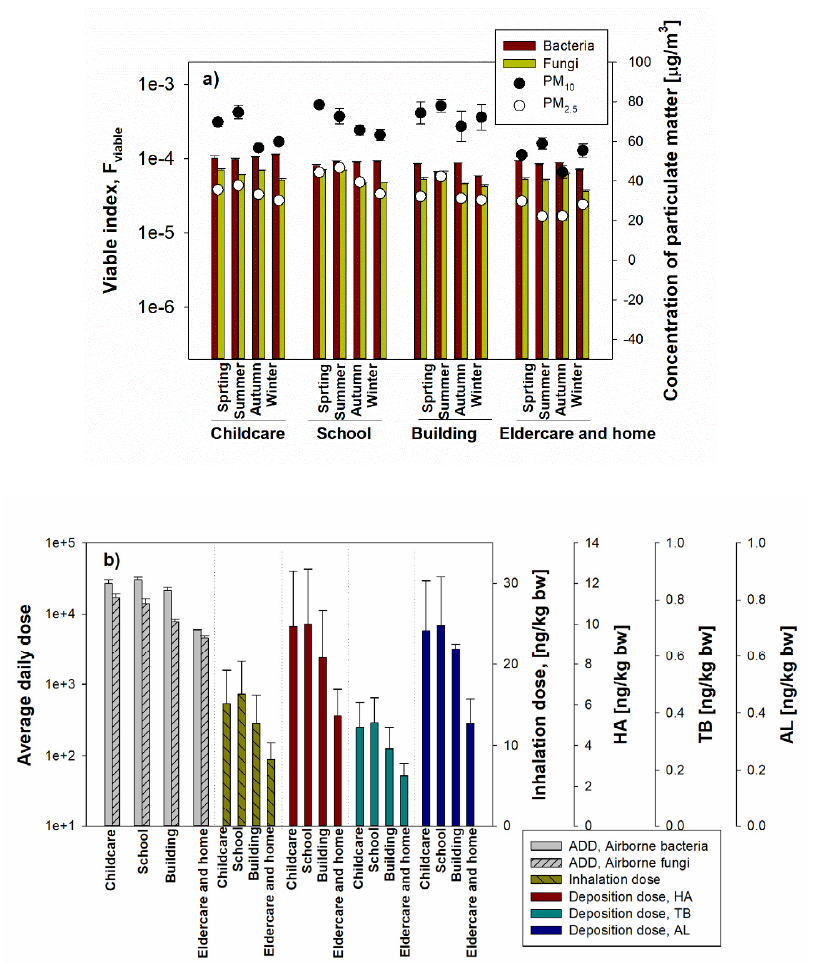
Figure 8. Microbiological viable index of total particles in different environments over four seasons ( a ), the average daily dose (ADD) ( b ) based on the total microbes (airborne bacteria and fungi) and inhalation/deposition dose based on the particle number concentrations. Deposited mass was calculated for the head airways (HA), the tracheobronchial (TB), the alveolar (AL) regions. The error bars represent one standard deviation.